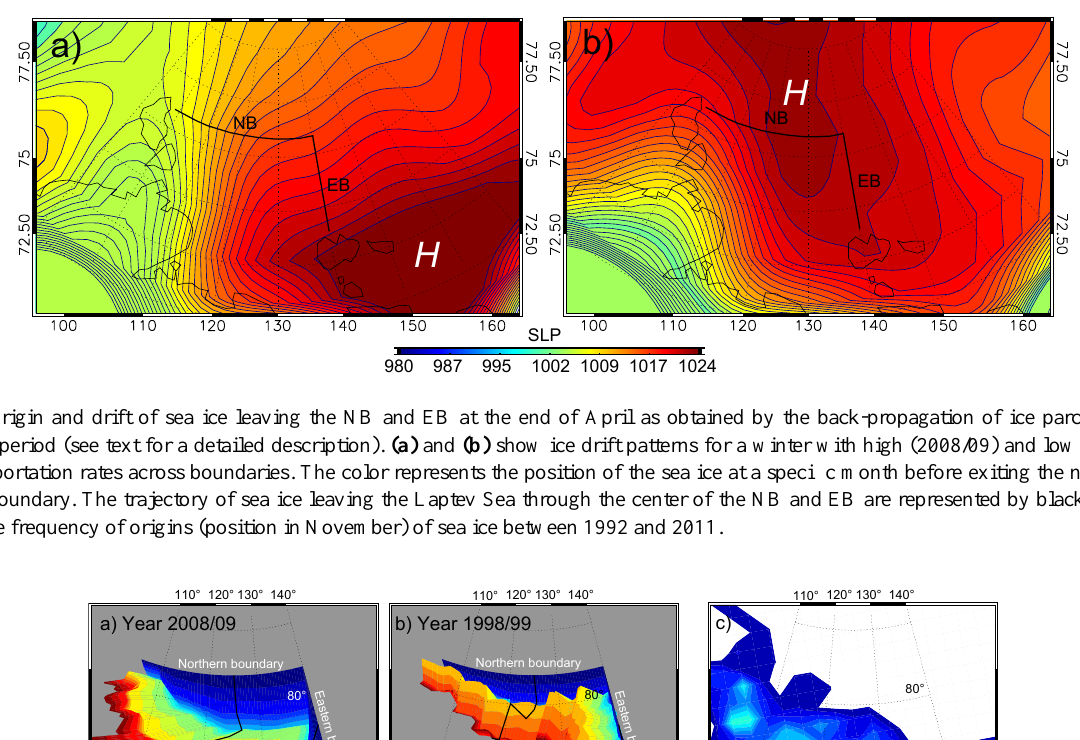
Fig. 9. Origin and drift of sea ice leaving the NB and EB at the end of April as obtained by the back-propagation of ice parcels over a 6-month period (see text for a detailed description). a) and b) show ice drift patterns for a winter with high (2008/09) and low (1998/99) ice transportation rates across boundaries. The color represents the position of the sea ice at a specific month before exiting the northern or eastern boundary. The trajectory of sea ice leaving the Laptev Sea through the center of the NB and EB are represented by black lines. c) shows the frequency of origins (position in November) of sea ice between 1992 and 2011.